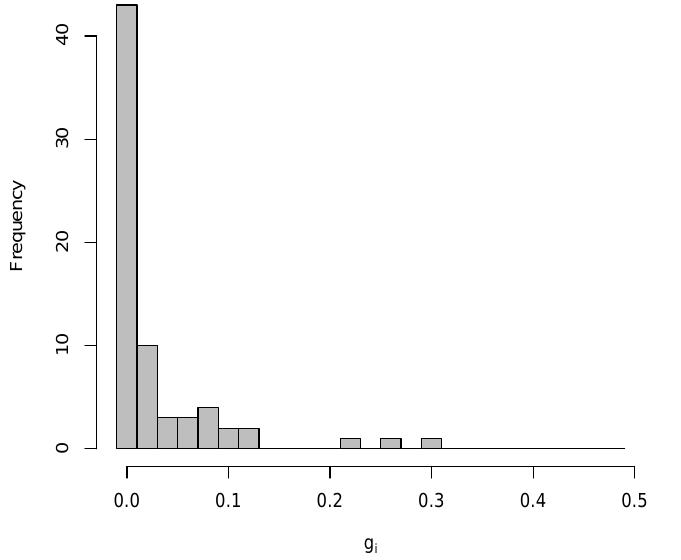
Figure 1. PIRLS 2016 reading: Histogram of proportion of guessers parameters g i in the 4PGL model.